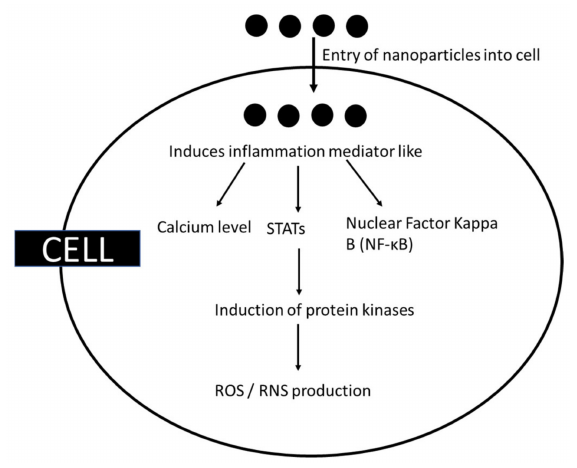
Figure 2. ROS generation by metal nanoparticles.